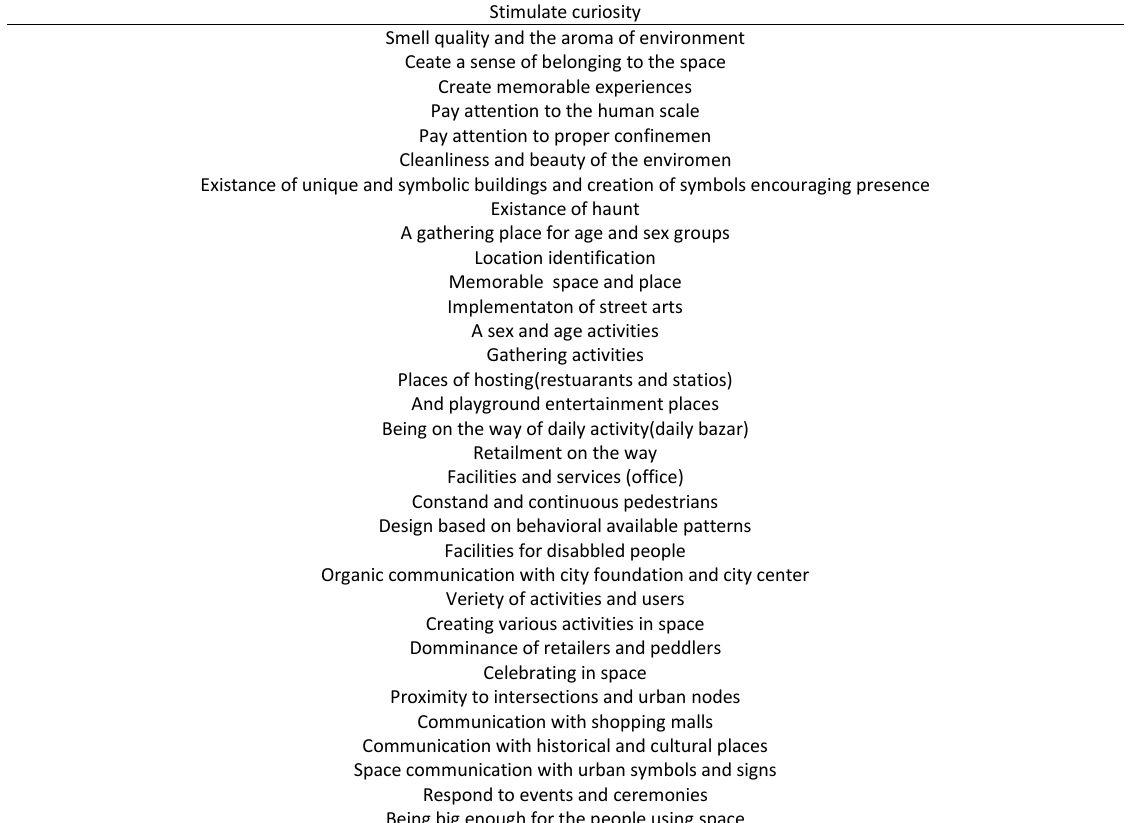
Table 2: Semantic dimension subset indices